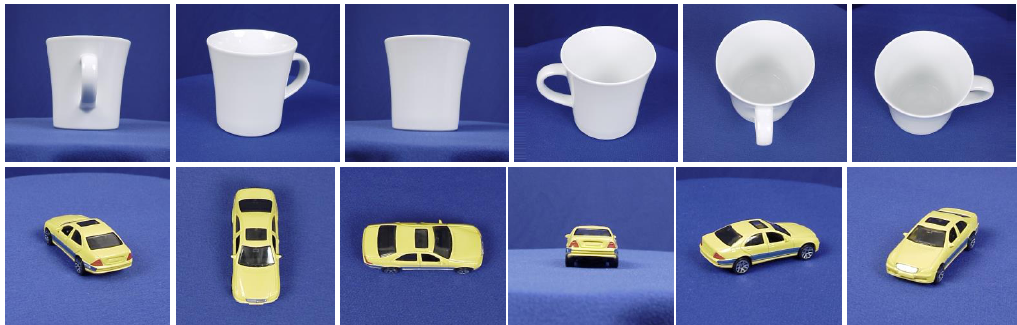
Figure 5. Sampling cropped images of two sets from ETH-80